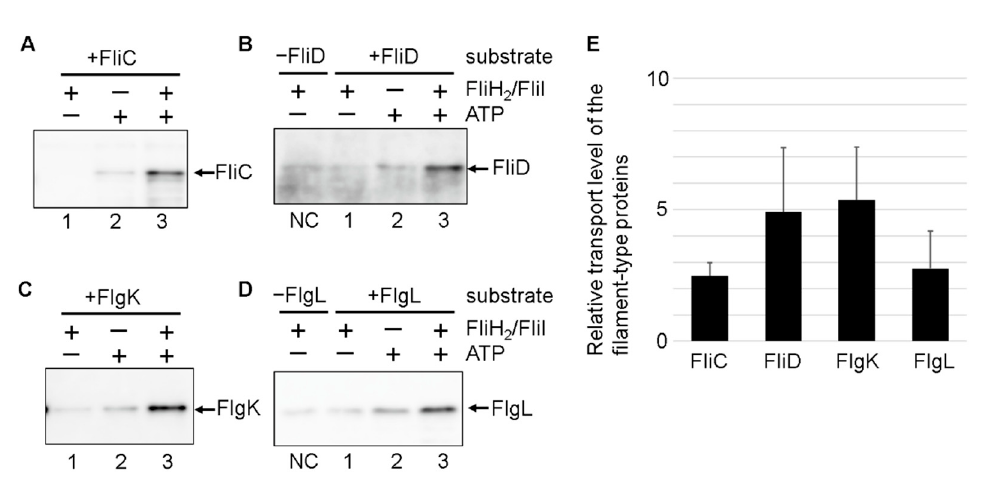
Figure 3. In vitro protein transport of the filament-type substrates into the IMVs. IMVs after completion of the hook were mixed with reaction mixture containing 0.25 µM of FliJ and 2 µM of the filament-type substrate–chaperone complex: FliC/FliS ( A ), FliD/FliT ( B ), FlgK/FlgN ( C ), and FlgL/FlgN ( D ). The transport assay was conducted with (+) or without ( − ) the FliH 2 /FliI complex (1.5 µM) and ATP (5 mM). The bands in Lane 1 in ( B ) and ( C ) are cross-reacting bands because similar bands were detected in the assay not containing the substrates (Lane NC in ( B ) and ( C )). ( E ) The transport levels of the filament-type protein relative to those without the FliH 2 /FliI complex. The immunoblot band intensity was measured using Image J software. The relative transport level was calculated by dividing the band intensity of Lane 3 by that of Lane 2 after subtraction of that of Lane 1 (without ATP). Data from three independent experiments were averaged. Error bar represents standard deviation.